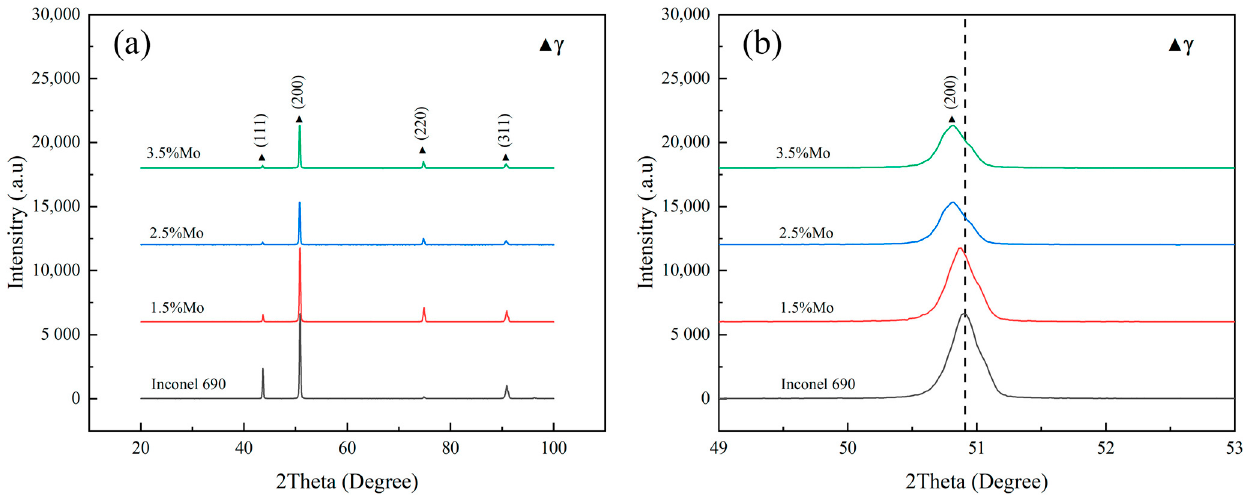
Figure 6. ( a ) X-ray diffraction curves of samples with different Mo contents; ( b ) Magnified image of (100) peaks shifted to the left.